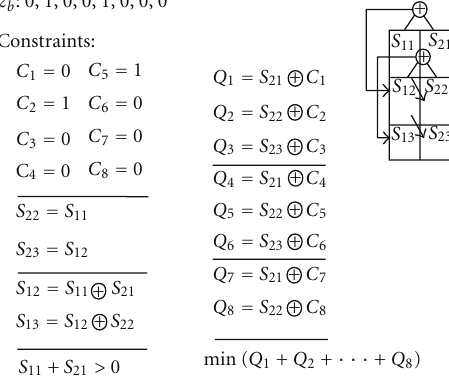
Figure 2: An example of a network with 8 data bits and 2 SR bits.